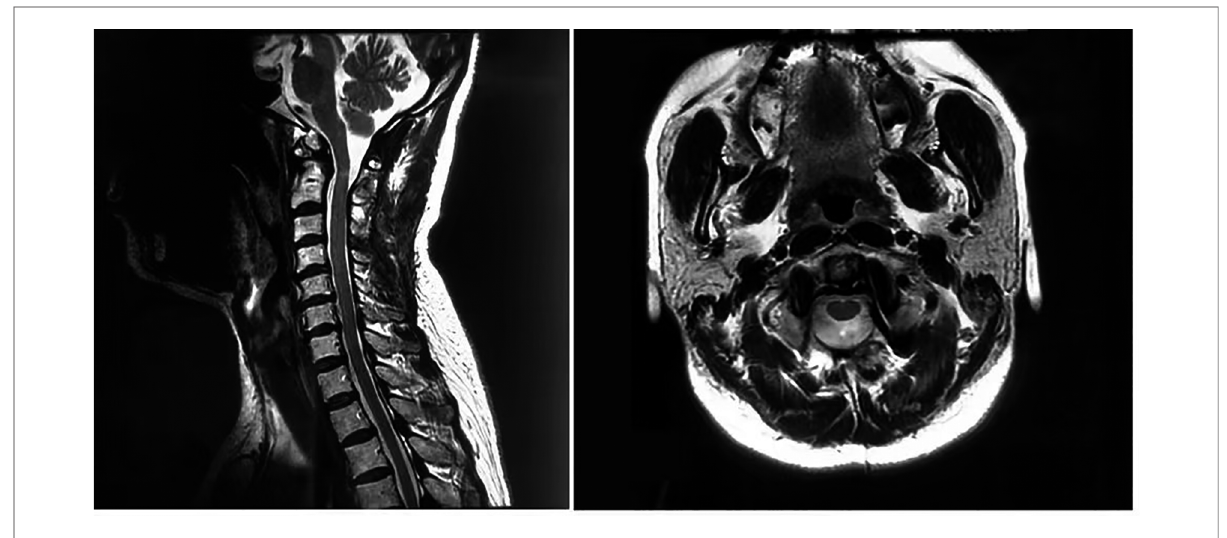
FIGURE 7 Sagittal and axial 3-month postoperative magnetic resonance imaging showing the complete disappearance of the retro-odontoid